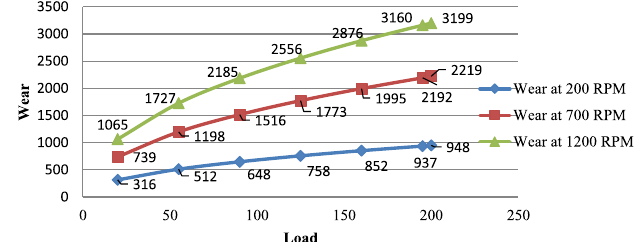
Fig. 6. Wear vs load at constant RPM for Al6061